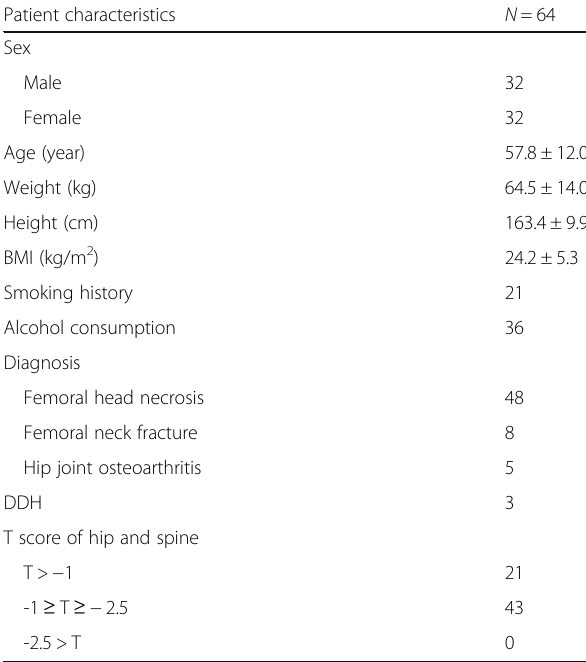
Table 1 Demographic data (mean ± SD) Patient